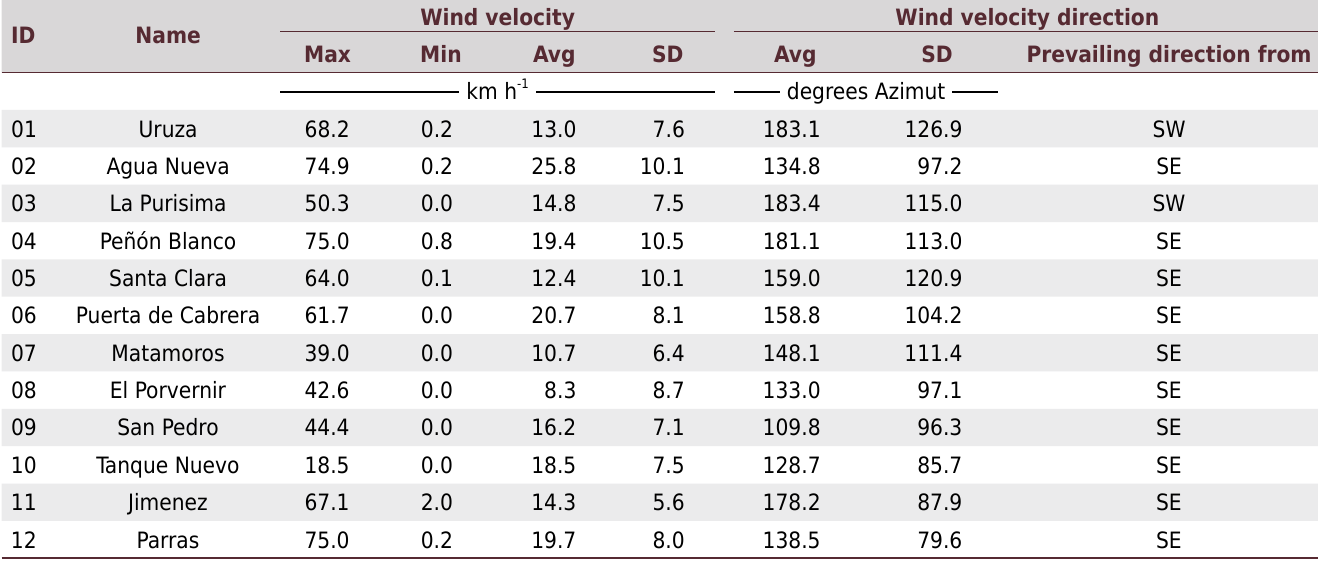
Table 3. Statistical parameters for wind in the study area ID